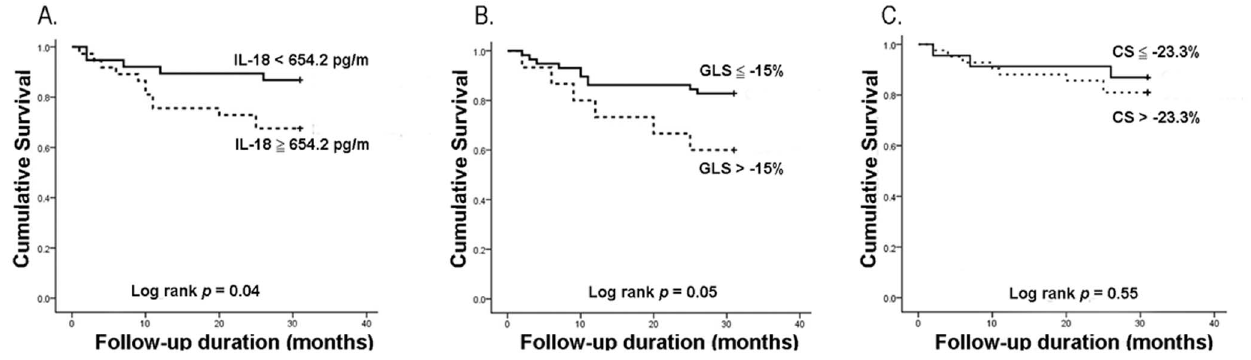
Figure 1. Kaplan-Meier survival curves of all-cause mortality in clinically stable hemodialysis patients using the cutoff values of interleukin (IL)-18 (A), left ventricular global peak systolic longitudinal strain (GLS) (B), and circumferential strain (C).